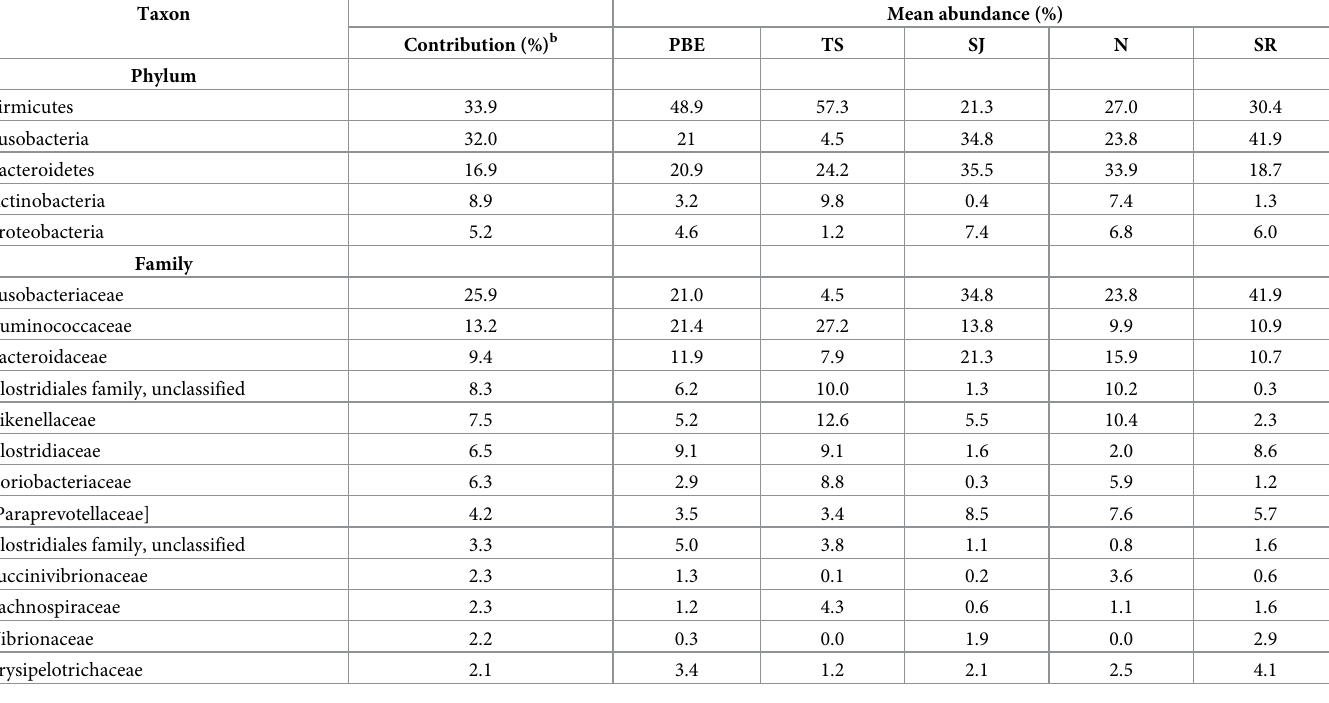
Table 1. SIMPER analysis results comparing the gut microbiota composition of the studied harbor seal colonies a . PBE = Punta Banda Estuary, TS = Todos Santos Island, SJ = San Jeronimo Island, N = Natividad Island, SR = San Roque Island.